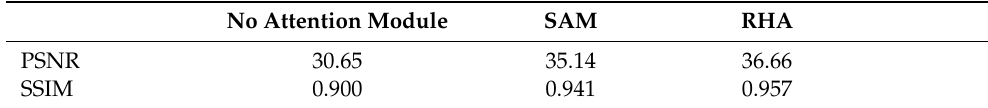
Table 4. Effect of the proposed attention module